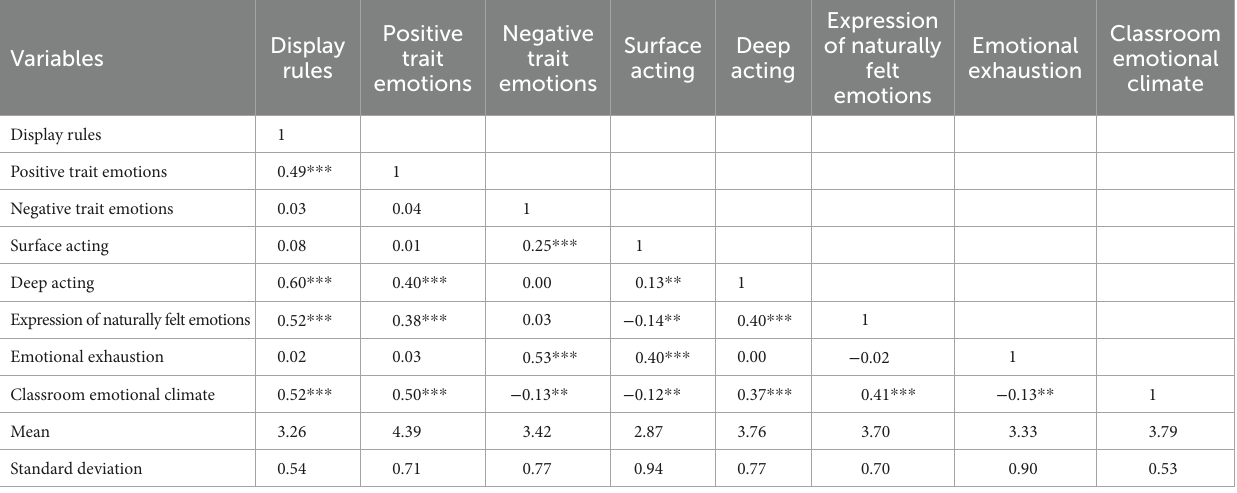
TABLE 2 Correlation matrix among the latent